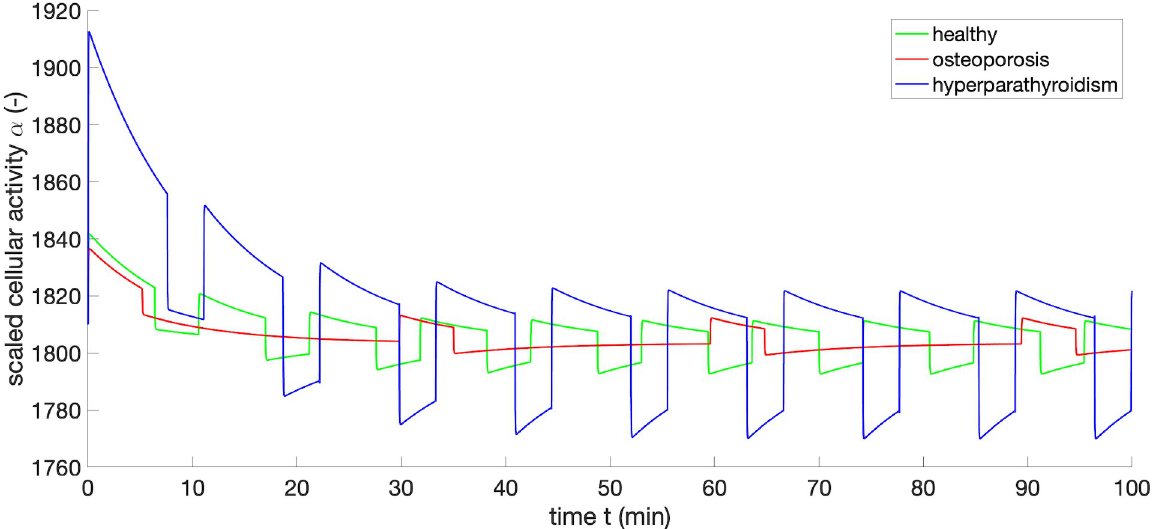
Fig 5. Scaled activity α for healthy person, patient with idiopathic osteoporosis and hyperparathyroidism. Simulation parameters are given in Table 1 and S2 Table.